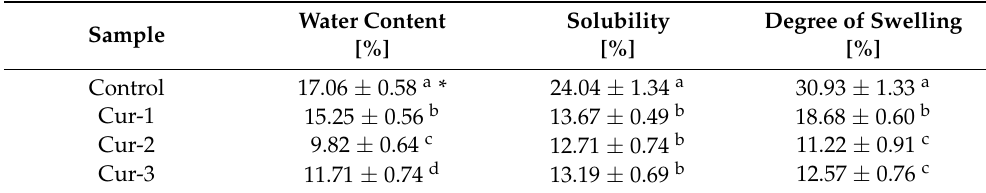
Table 2. Determination of water content, solubility and swelling degree of the control film and the film with curcumin added at different